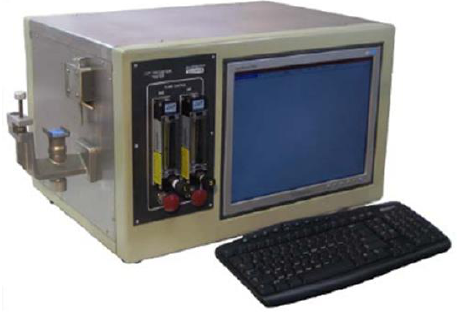
Figure 6. BCIRA hot distortion tester.